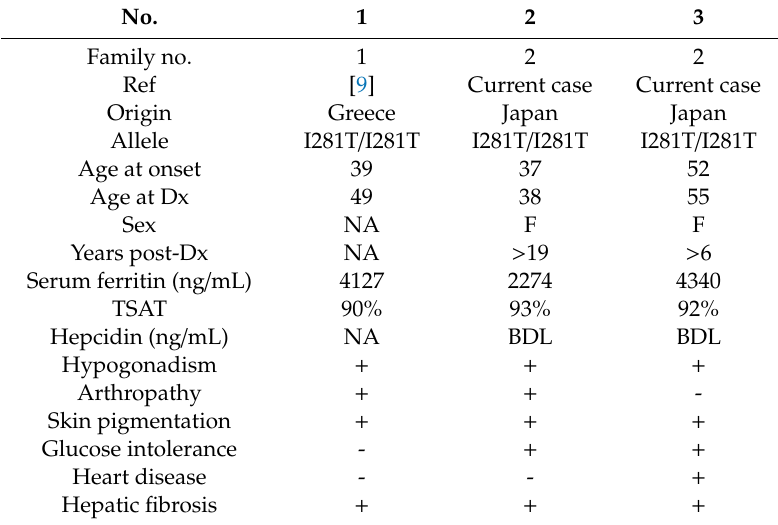
Heart disease - Hepatic fibrosis